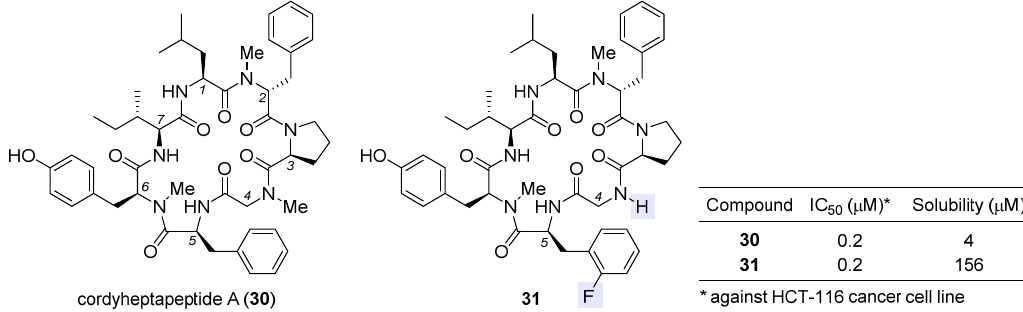
Figure 7. Structures of natural cordyheptapeptide A ( 30 ) and synthetic analogue 31 , with the inset table comparing their IC 50 values against HCT-116 cancer cell line and aqueous solubility.